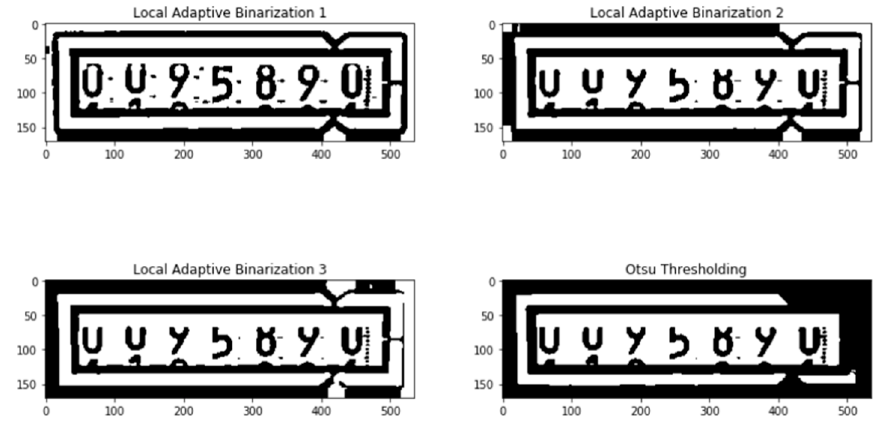
Figure 9. Image processing result.